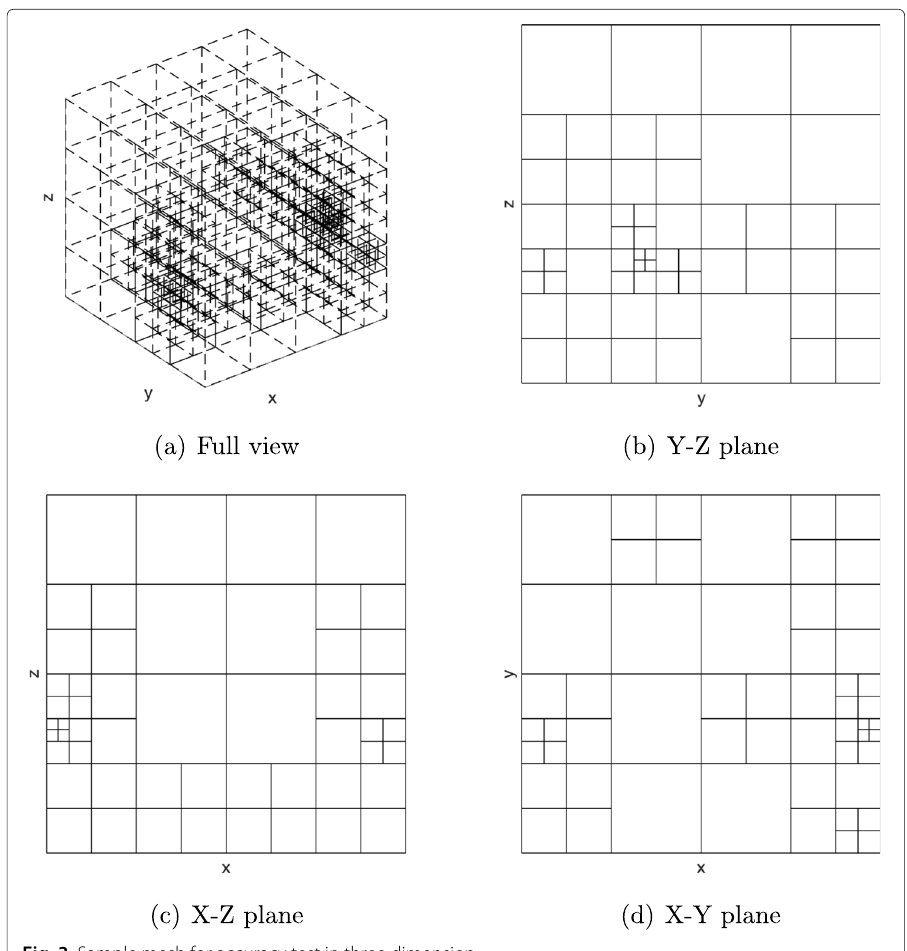
Fig. 3 Sample mesh for accuracy test in three